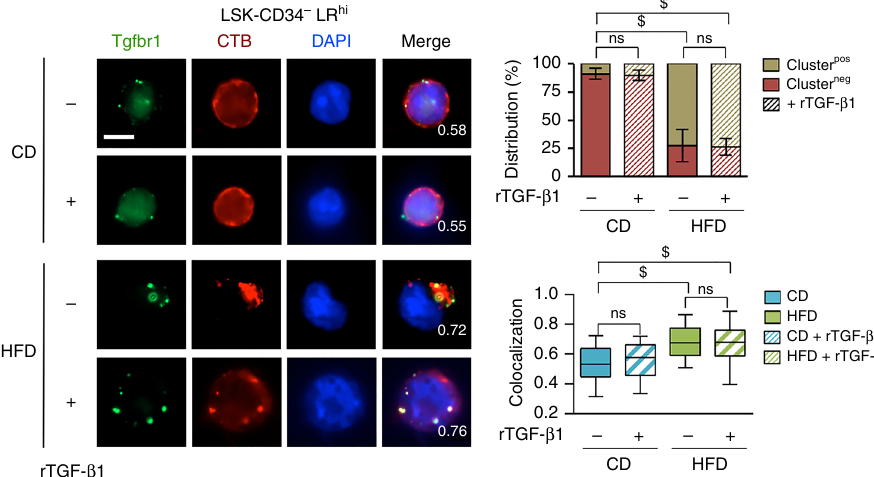
Fig. 8 rTGF- β 1 does not changed Tgfbr1 clustering within LR on LSK-CD34 − LR hi cells. Single-cell immunostaining is performed and data show that HFD induces cluster formation of LR (CTB, red), in which Tgfbr1 (green) is typically condensed, and that rTGF- β 1 injection do not change the redistribution of LR clustering. Data on the left panel show examples of representative single-cell immunostaining for CD and HFD-fed mice, treated or not by recombinant TGF- β 1 (rTGF- β 1 injected in vivo at 1.3 µ g/kg) twice per week during the 4 weeks of the diet, n = 2 mice per experimental group. Microscopy is performed on LSK-CD34 − LR hi cells isolated by FACS. White scale bar represents 5 µ m. Graph and box-and-whisker plots, showing statistics of the distribution of LR clustering and colocalization on LSK-CD34 − LR hi cells ( n > 40 cells) respectively, are shown on the right panel. For top right graph, data show mean ± SD; for bottom right box-and-whisker plots, data are presented as median (central line), fi rst and third quartiles (bottom and top of boxes, respectively), and whiskers (extreme values); ns, non-signi fi cant ( P > 0.05); $, P < 0.0001 (two-tailed unpaired Student ’ s t